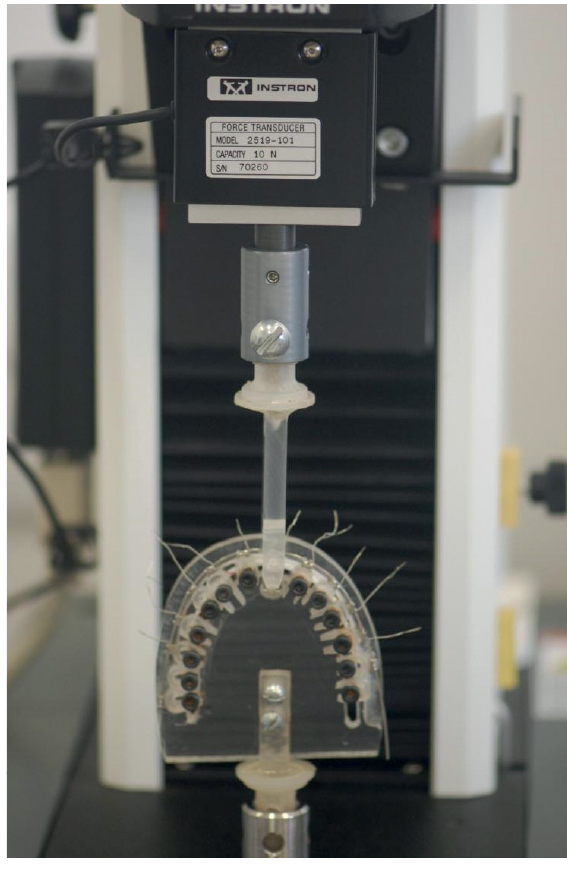
Figure 2. Tip of the Universal testing machine applying a bucco-lingual pressure to the acrylic structure.